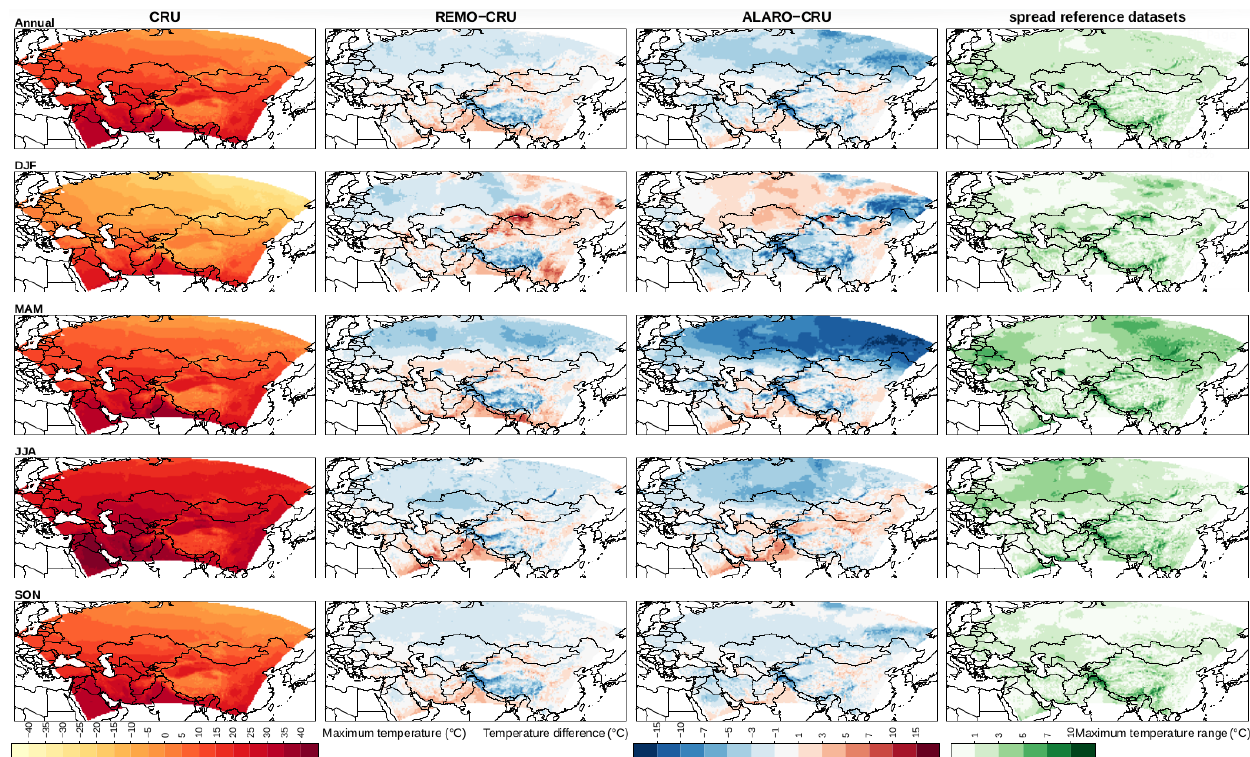
Figure 8. Left column: maximum air temperature ( ◦ C) at 2m height over the CAS-CORDEX domain based on the observational CRU dataset for the 1980–2017 period on an annual level and for winter (DJF), spring (MAM), summer (JJA), and autumn (SON). Middle columns: difference in maximum temperature between the models and CRU. Right column: the range in maximum temperature ( ◦ C) between the different reference datasets (CRU and